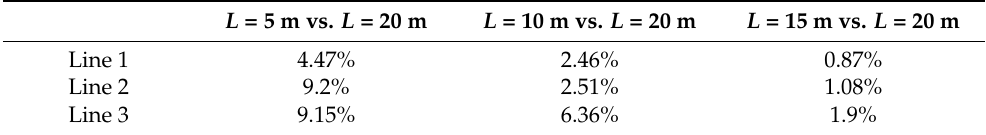
Figure 5. Velocity profiles along line 3 for different L values. The portion of the velocity profile between the black dashed lines is inside the platform. Table 2. Percentage mean velocity differences on probe lines 1, 2 and 3 obtained in the simulations with external box length of L = 5-10-15 m, with respect to the L = 20 m